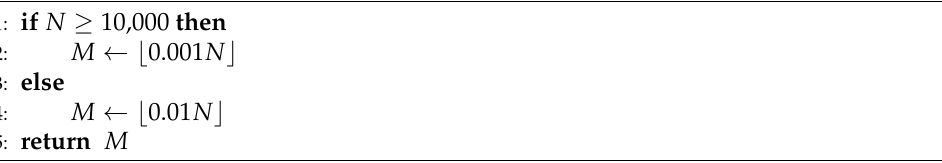
Algorithm 3 ComputeTuningPhaseLength ( N